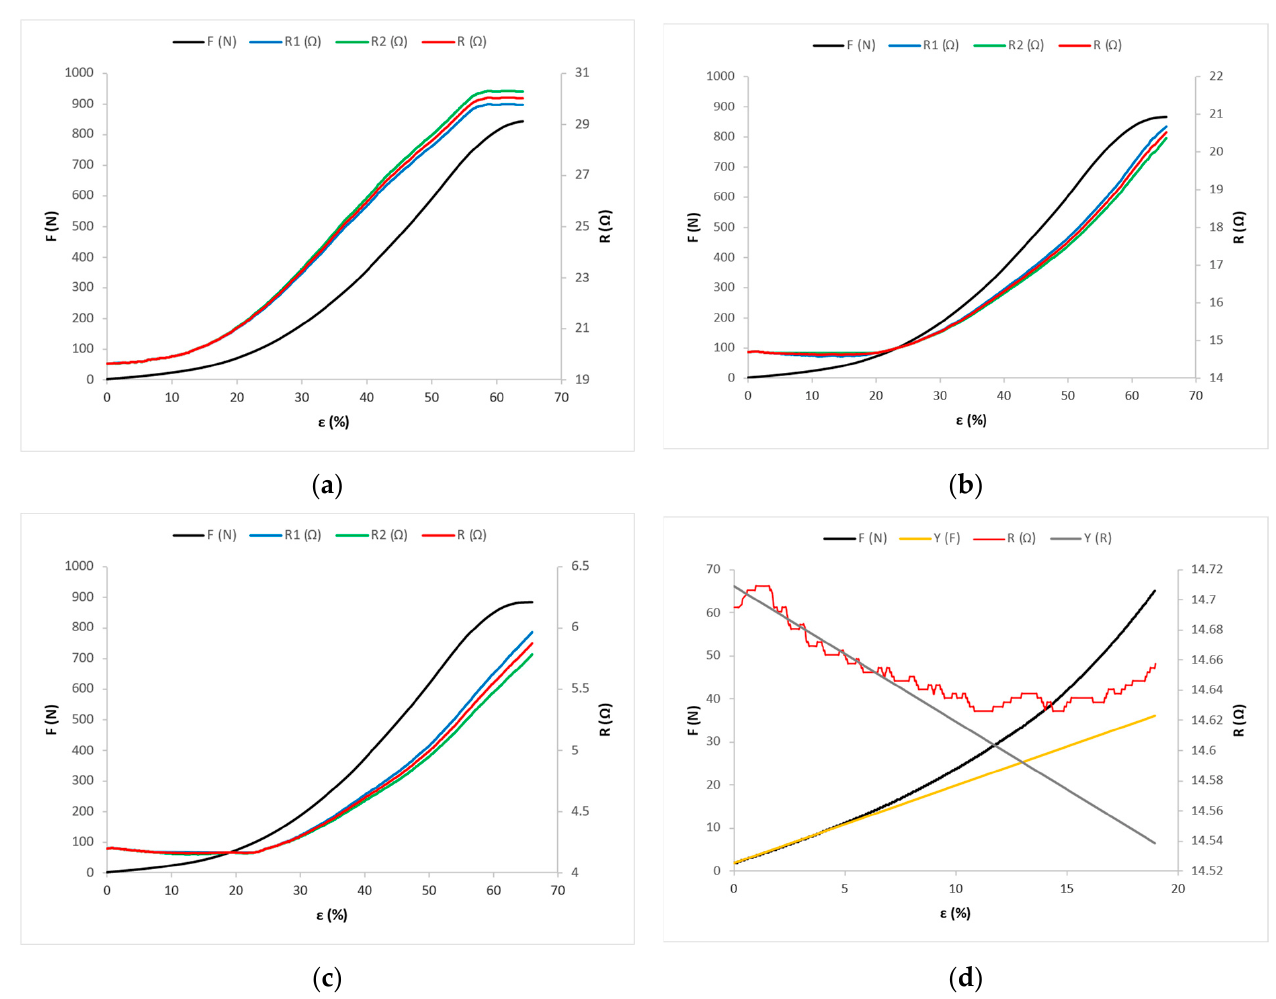
Figure 7. Force–elongation (F- ε ) and electrical resistance–elongation (R- ε ) diagrams for fabric samples cut at a 45° angle: ( a ) for sample X-45; ( b ) for sample Y-45; and ( c ) for sample Z-45. ( d ) Experimental and mathematical models of F- ε and R- ε curves for sample Y-45.